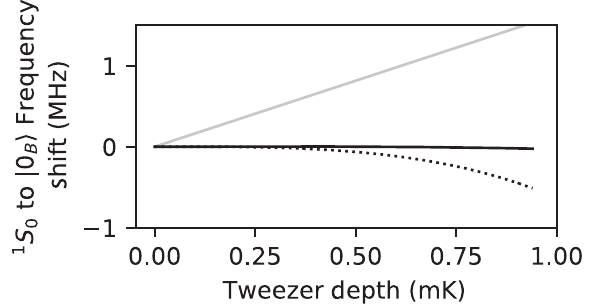
8. We plot the frequency shift on the 1 S 0 ↔ 3 P 1 , m ¼ 0 i ) transition for the experimental conditions described (or j 0 B in the main text: θ ¼ 0 (gray line), θ ¼ θ with a 24 G magic (black line), and 7 G (dashed line) magnetic field. These plots use α T ¼ 140 a 3 α S ¼ 760 a 3 0 , 0 , and the ground-state polarizability quoted in the